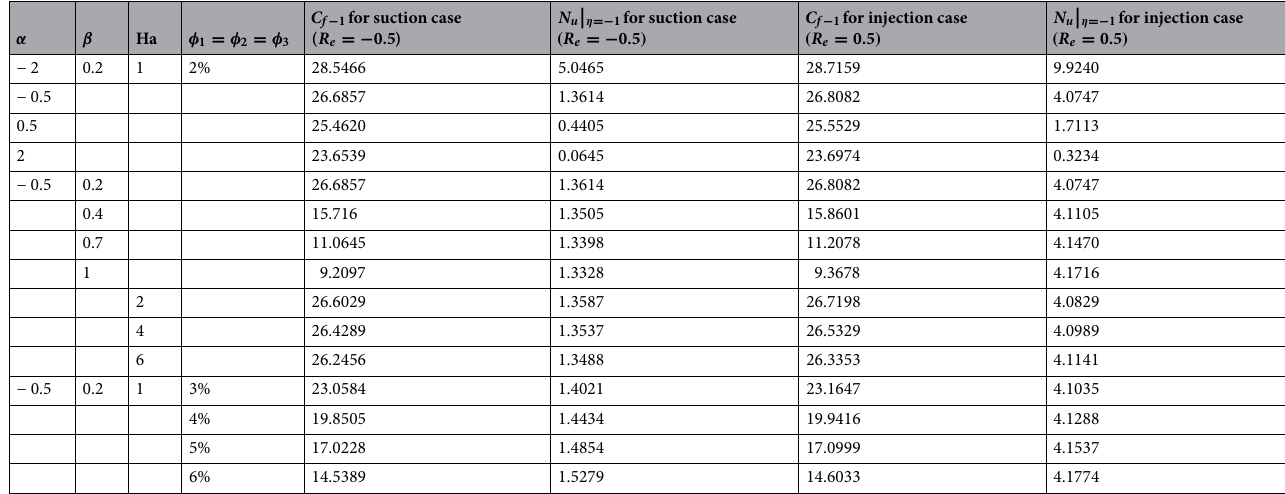
Table 3. The impact of α , β , Ha, φ 1 , φ 2 , and φ 3 on the SFC and Nusselt number for suction and injection case, 1, S 3, R d 1, N 1 1. for R 0 = = = =